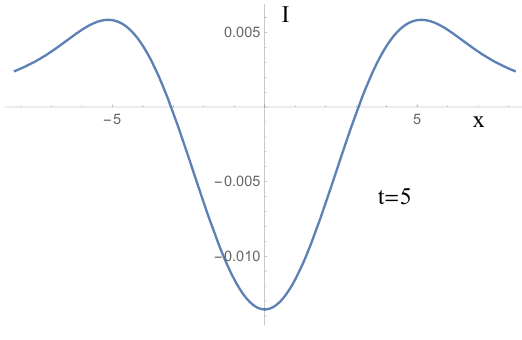
Figure 5. Same as in Figure 3, with t =